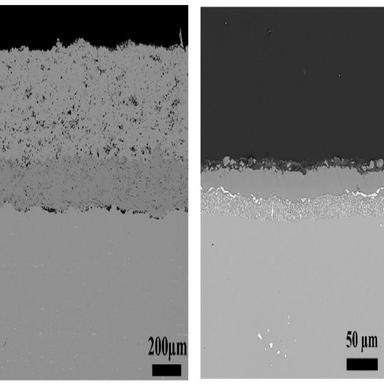
(a) SEM of the outer coating (MCrALY/TBC) and (b) internal diffusion coating.